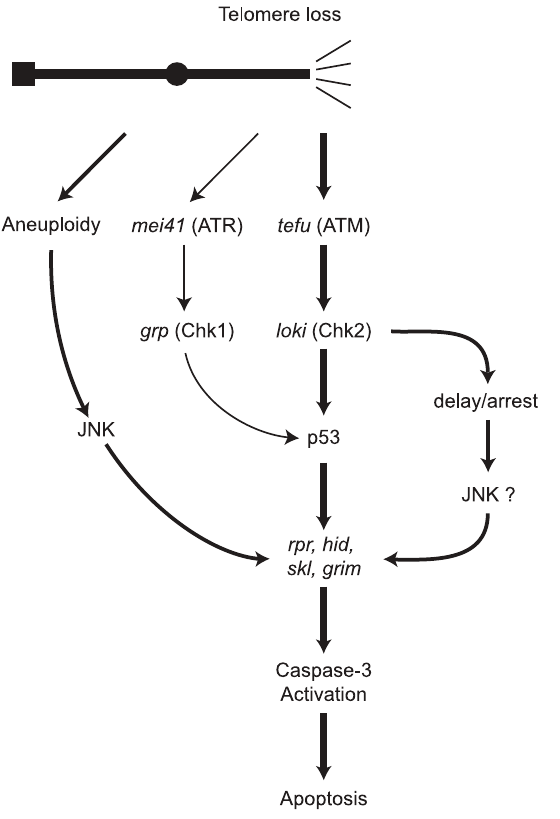
Figure 8. A model of pathways for eliminating cells that have lost a telomere. Following recognition of the missing telomere, ATM and ATR phosphorylate checkpoint kinases Chk2 and Chk1. Caspase- dependent cell death is mediated by signaling through p53, or alternatively, via the aneuploidy-triggered pathway. A second p53- independent cell death pathway is mediated through Chk2. Portions of this model are based on identified DNA damage response pathways in Drosophila and the role of ATM in mammalian cells